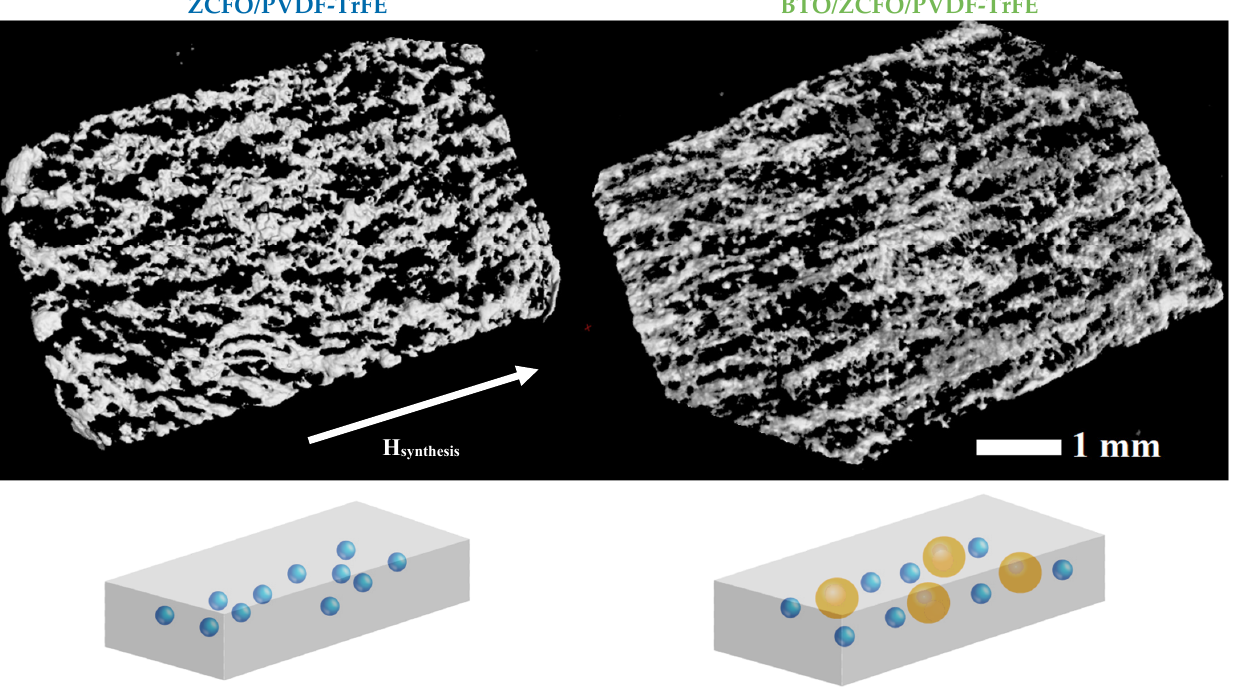
Figure 2. Post-processed 3D XCT scans of ZCFO/PVDF-TrFE ( left ) and BTO/ZCFO/PVDF-TrFE ( right ) samples, demonstrating the filler subsystem without the polymer matrix.